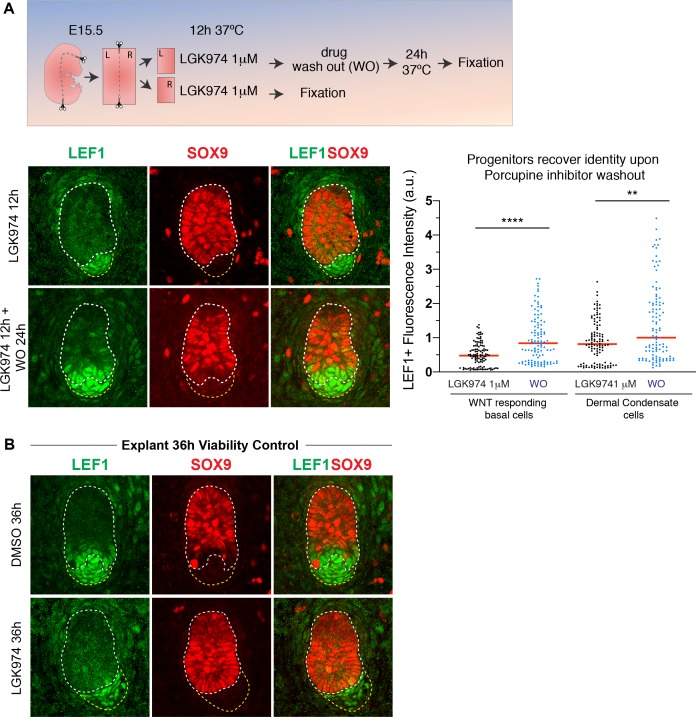
Hair bud progenitors revert their fate after WNT inhibitor washout.(A) Experimental design and results of pharmacological WNT inhibition and washout in embryonic skin explants exposed to 1 mM porcupine inhibitor LGK974. Immunofluorescence and quantifications of normalized LEF1 pixel intensity. Note basal progenitors and dermal condensate restore LEF1/WNT signaling and WNThi bud cells recover their original (SOX9neg) fate after inhibitor washout (n = 109 developing hair follicles ****p<0.0001; **p=0.0024 Mann-Whitney test). (B) Control experiment showing the viability of E15.5 embryonic skin explants after 36 hr of 1 mM LGK974 and DMSO vehicle treatment. Explants were plated at the bud stage and in the DMSO control, they developed to the hair peg stage by 36 hr. Scale Bar 20 μm.Figure 6—figure supplement 3—source data 1.Source data for the graphs shown in Figure 6—figure supplement 3A.